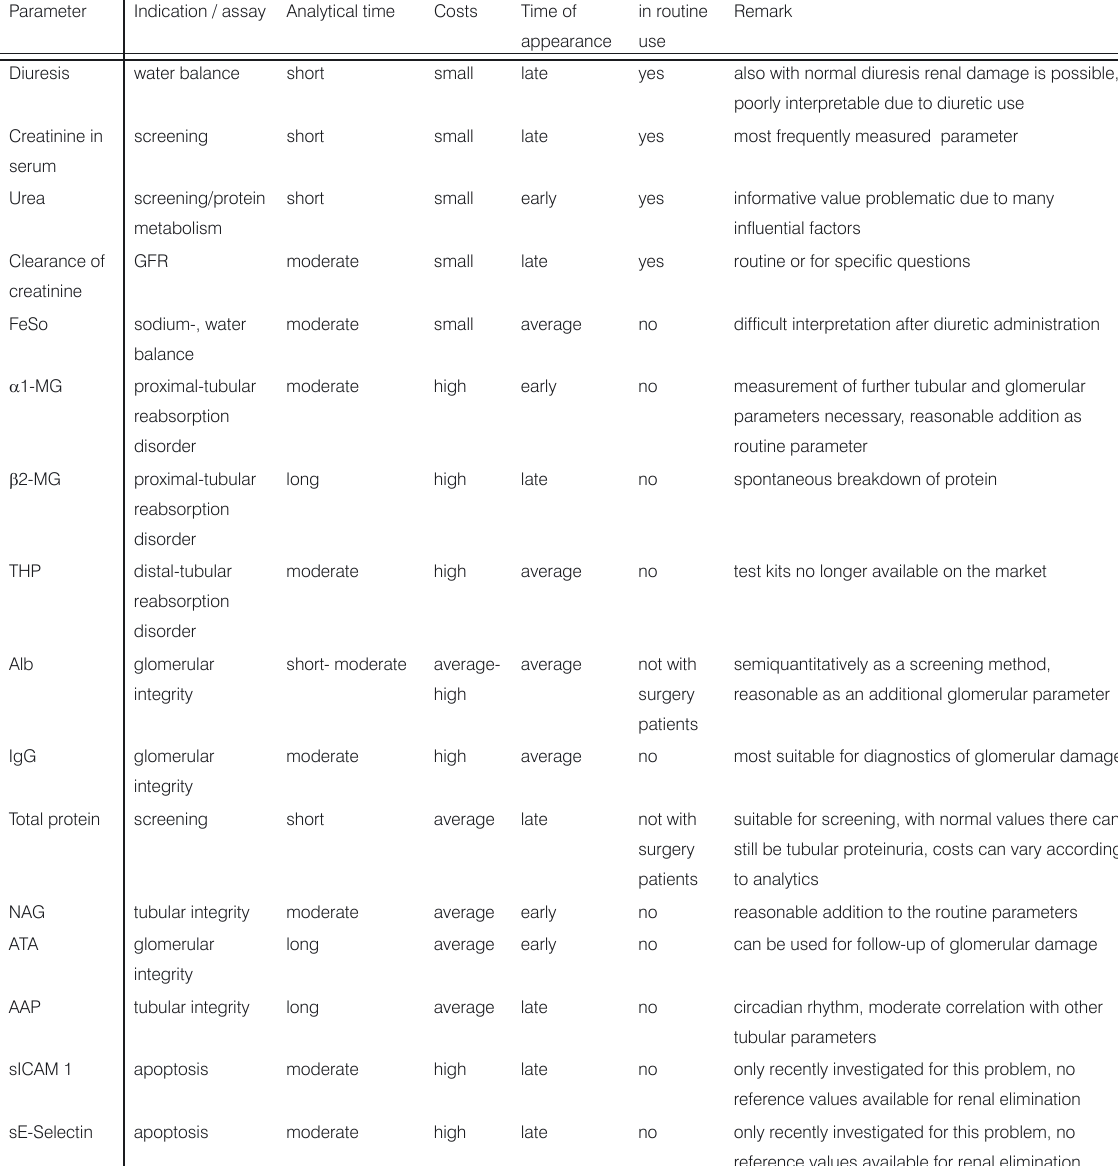
Table 3. Evaluation of the examined